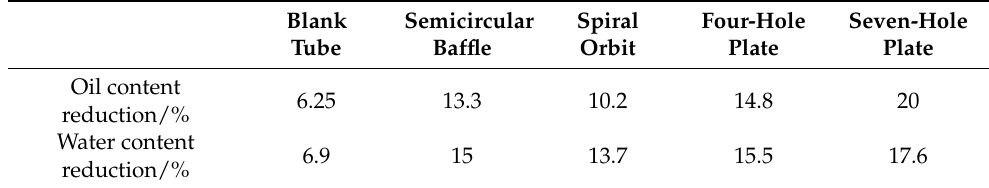
Table 2. Comparison of separation